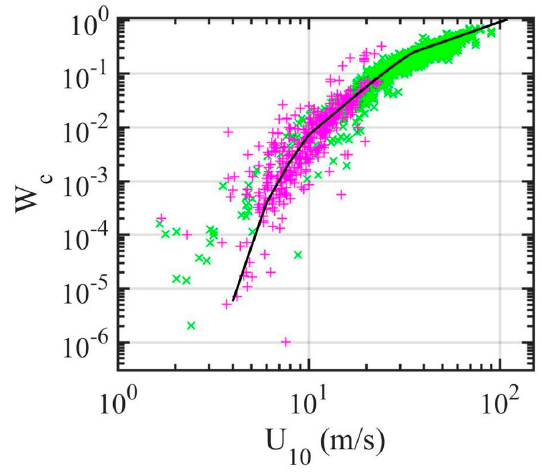
Figure 3. Whitecap fraction dependence on wind speed; green crosses: data retrieved from microwave radiometer measurements; magenta plus signs: optical measurements; black solid line: the whitecap model (9–10).